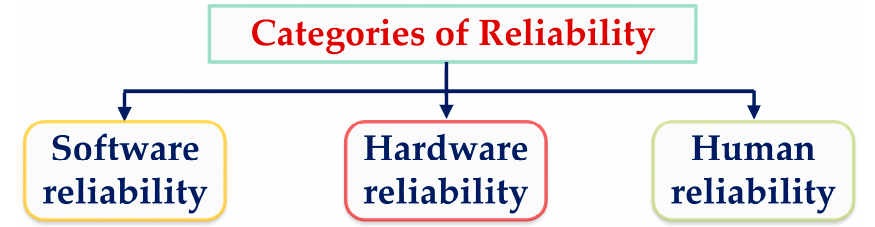
Figure 16. Categories of reliability.